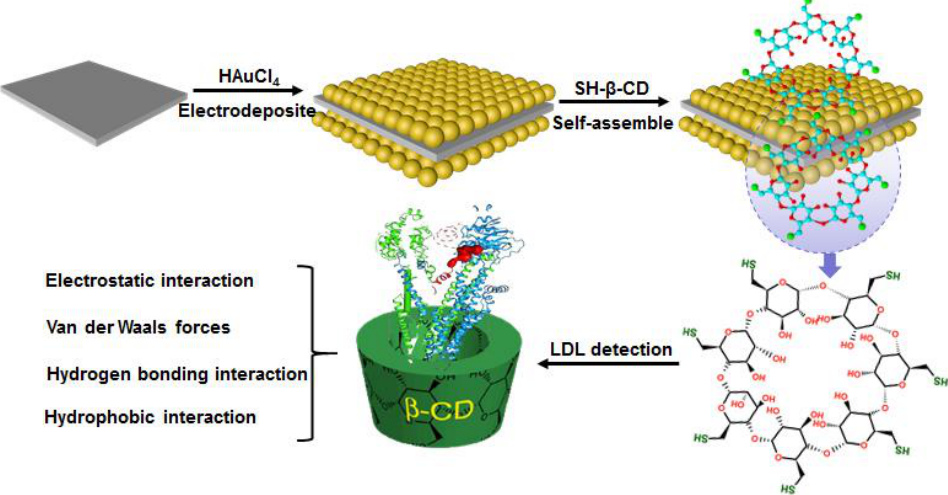
Figure 1. Schematic illustration of preparation of β -CD-Au modified needle for LDL recognition and quantification.